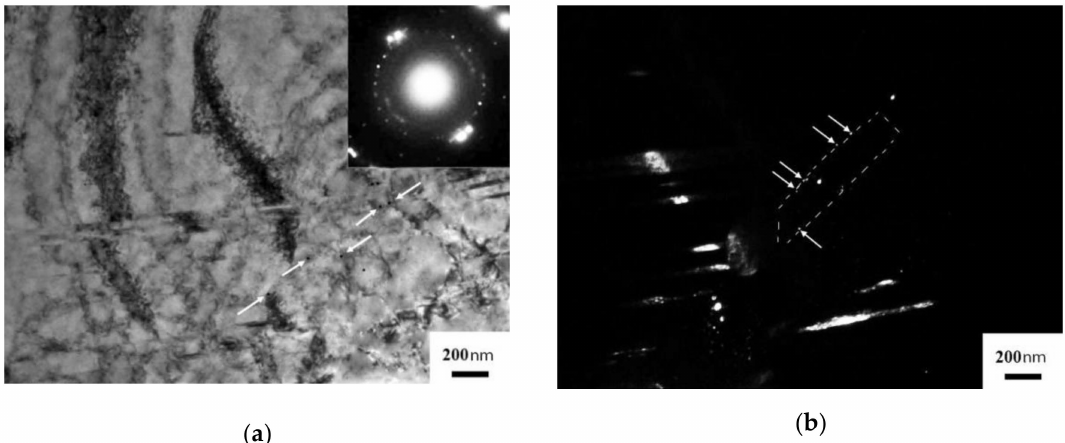
Figure 6. Structure of the sample after ECAP with wire forming and aging (longitudinal section): ( a ) TEM—light-field image (arrows show secondary phase precipitates) and ( b ) TEM—dark-field image (arrows show secondary phase precipitates).